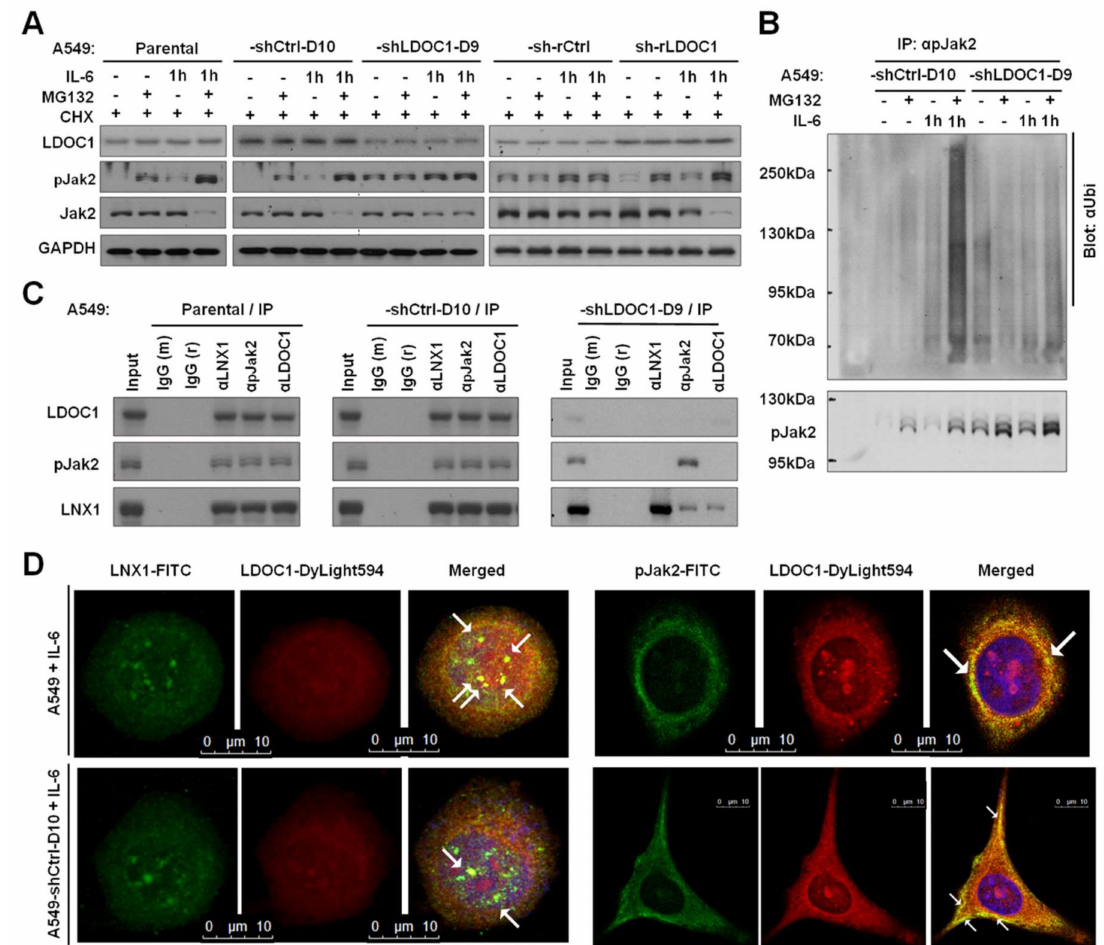
Figure 6. LDOC1 interacts with Ligand Of Numb-Protein X 1 (LNX1) to promote phospho-JAK2 (pJAK2) degradation through the ubiquitin–proteasome pathway. ( A , B ) LDOC1 enhances proteasomal degradation ( A ) and ubiquitination ( B ) of pJAK2 in basal and IL-6-stimulated A549-derived cell lines. A549-derived cell lines were starved overnight and pretreated with CHX (100 µ g/mL), either alone or with proteasome inhibitor MG132 (20 uM) for 3 h before IL-6 (100 ng/mL) stimulation. The cells were lysed in an NP-40 lysis buffer containing MG132 (20 µ g/mL) and ubiquitin aldehyde (20 µ g/mL) to inhibit isopeptidase activities. ( A ) Western blotting was performed to examine the levels of indicated proteins. ( B , C ) The cell extracts were precleared with mouse or rabbit IgG (IgG m or IgG r , respectively) before being immunoprecipitated using antibodies against either pJAK2 ( B , C ) or against LDOC1 and LNX1 antibodies ( C ). The input and the Immunoprecipitation (IP) fractions were analyzed through immunoblotting (blot) using antibodies that recognized the indicated proteins. After being stripped, the membrane was reblotted with an anti-pJAK2 antibody ( B ). ( D ) Associations between LDOC1-LNX1 and LDOC1-pJAK2 in IL-6-treated A549 and A549-shCtrl-D10 cells. IL-6 stimulated cells were subjected to immunofluorescence assay (IFA) by using anti-LDOC1-DyLight594 (red), anti-LNX1-FITC (green), and anti-pJAK2-FITC (green), respectively. The 4 (cid:48) ,6-diamidino-2-phenylindole (DAPI, blue) was used for nuclear counterstaining. Images were captured using a confocal microscope. IP or IFA performed with IgG m or IgG r were used as negative